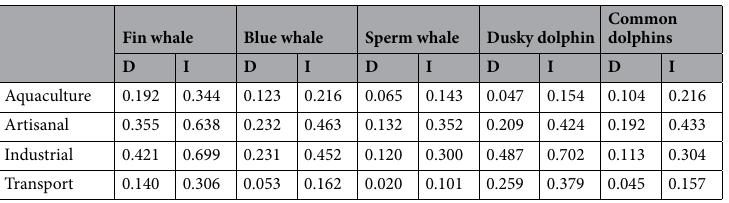
Table 4. Shoener’s D and Warren’s I similarity statistics for each cetacean species and vessel fleet